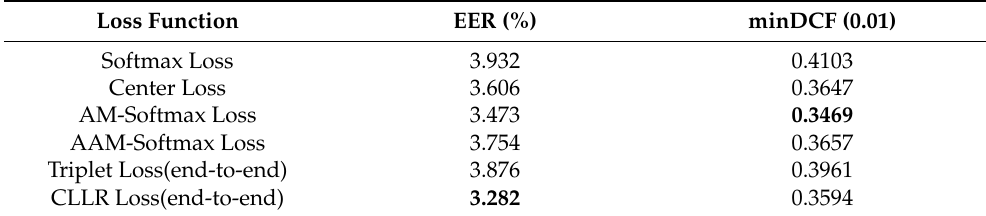
Table 2. Performance comparison of the TI-SV task using different loss functions on VoxCeleb.